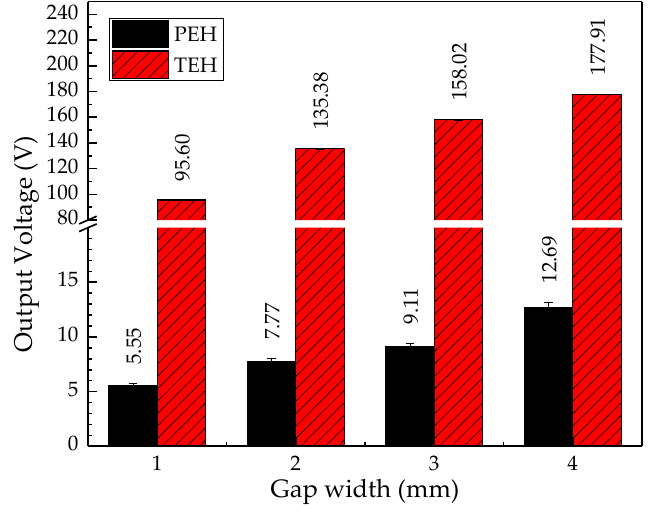
Figure 11. Output voltage of PEH and TEH.